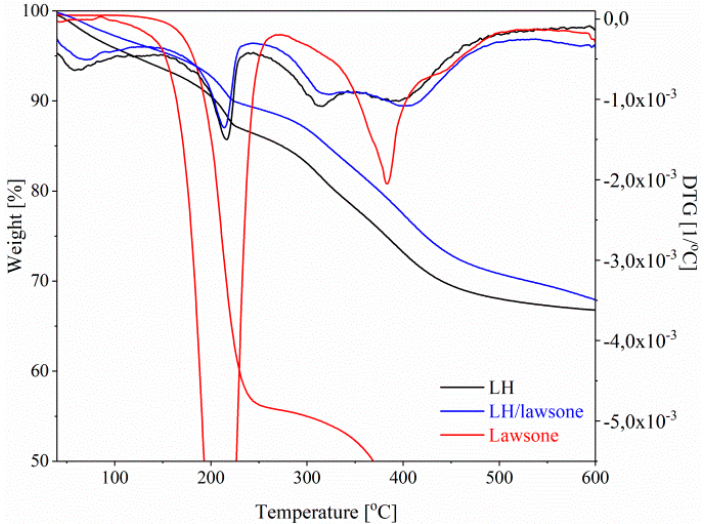
Figure 6. TGA/DTG curves for LH, LH/lawsone and lawsone. Figure 6. TGA / DTG curves for LH, LH / lawsone and